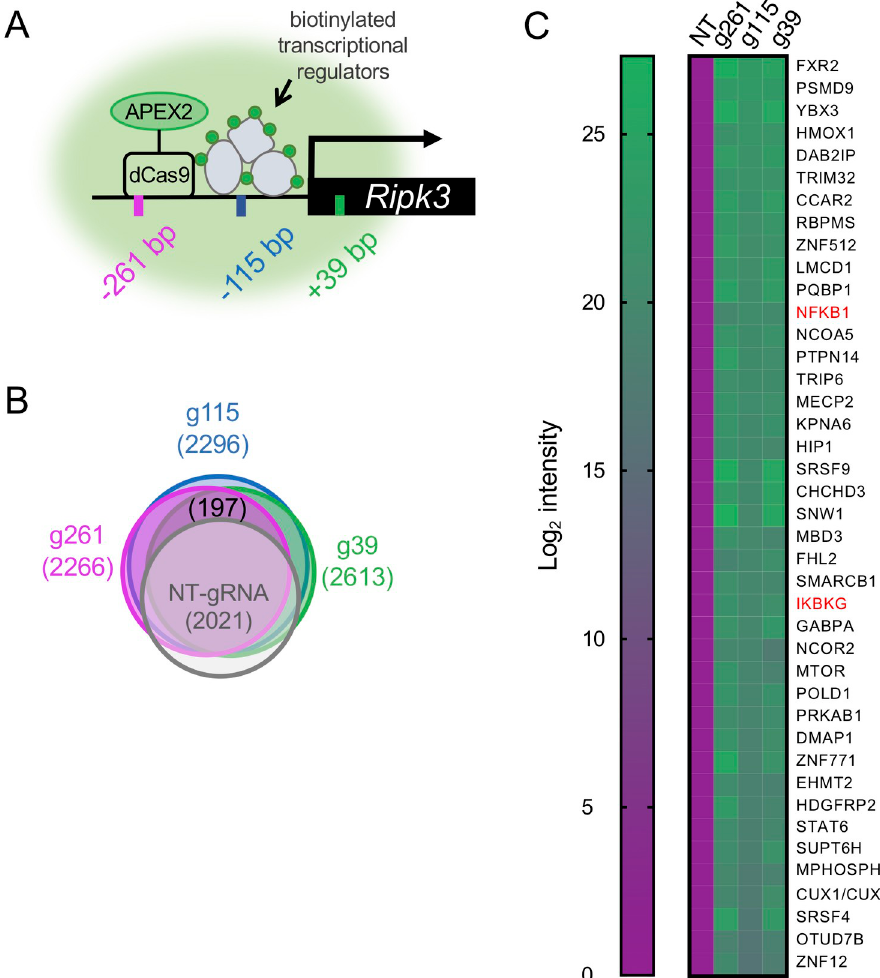
Fig 1. Genomic locus proteomics (GLoPro) reveals proteins associated with the Ripk3 locus in cultured ECs. (A) Schematic of GLoPro labeling of the Ripk3 locus in the MS1 EC line. Three targeting sgRNAs (color-coded bars) were designed to guide dCas9-APEX2 to different sequences upstream and downstream of the Ripk3 transcription start site (black arrow). Once targeted, dCas9-APEX2 biotinylates (green circles) proximal proteins associated with the Ripk3 locus (gray shapes), which are subsequently enriched and identified by mass spectrometry. (B) Venn diagram showing the number of proteins identified by GLoPro using the three Ripk3 -targeting sgRNAs (denoted as g39, g115, and g261) versus a non-targeting control sgRNA (denoted as NT-gRNA). See also S1 Table. (C) Heat map of high-stringency filtered GLoPro hits arranged by Log 2 intensity. The 41 proteins listed were identified by all three Ripk3 -targeting gRNAs and by annotated gene ontology (GO) terms including “nuclear as cellular component” and “transcription as molecular function.” NF κ B1 and IKBKG (listed in red) were further analyzed for validation as Ripk3 transcriptional modulators (see Figs